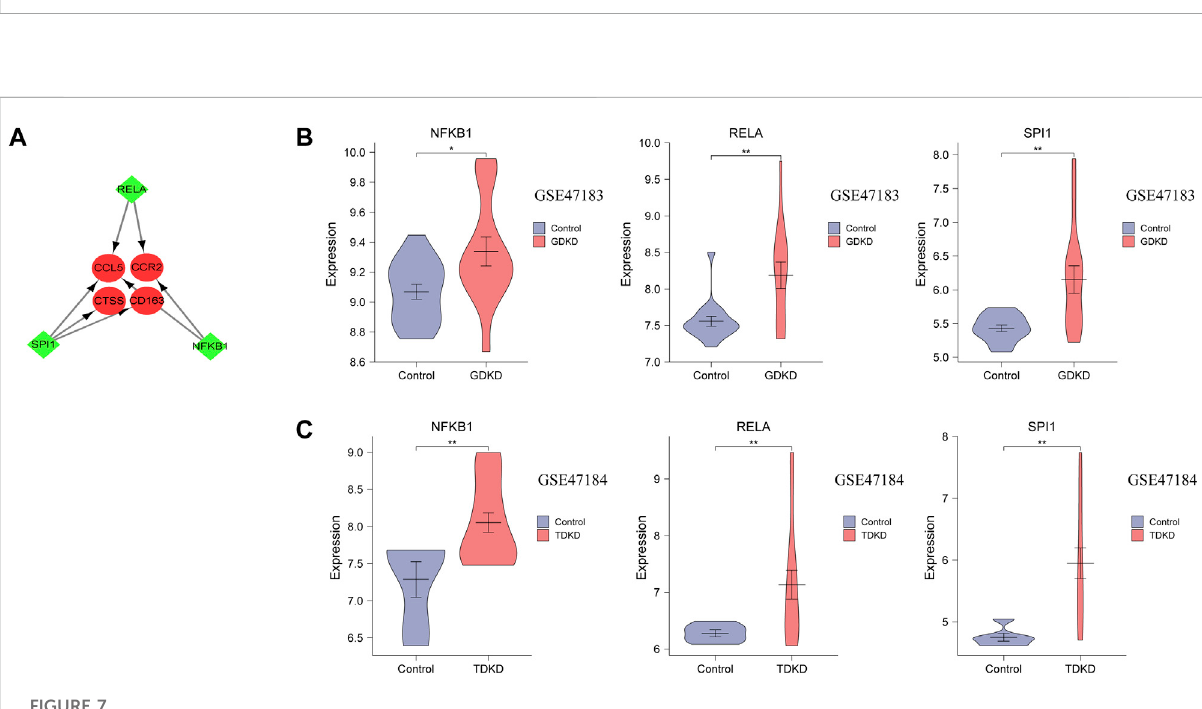
FIGURE 7 TFsregulatorynetworkandTFsexpressioninGSE47183andGSE47184. (A) GreendiamondsrepresentTFs,andredcirclesrepresenthubgenes. (B,C) mRNA level of TFs in GSE47183 and GSE47184. * p < 0.05, ** p < 0.01, *** p < 0.001. GDKD: glomerular diabetic kidney disease, TDKD: tubular diabetic kidney